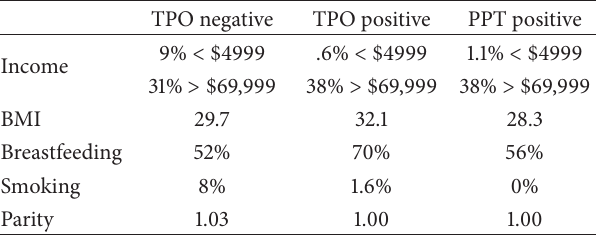
Table 1: Demographic characteristics by